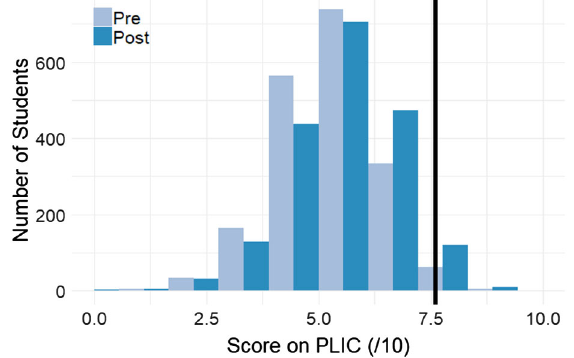
FIG. 1. Distributions of respondents ’ matched pre- and post- scores on the PLIC ( N ¼ 1911 ). The average score obtained by experts is marked with a black vertical line.